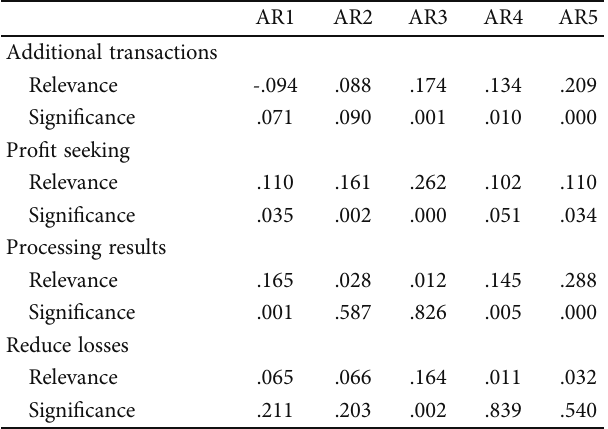
Table 4: Data of investor regression model. Model